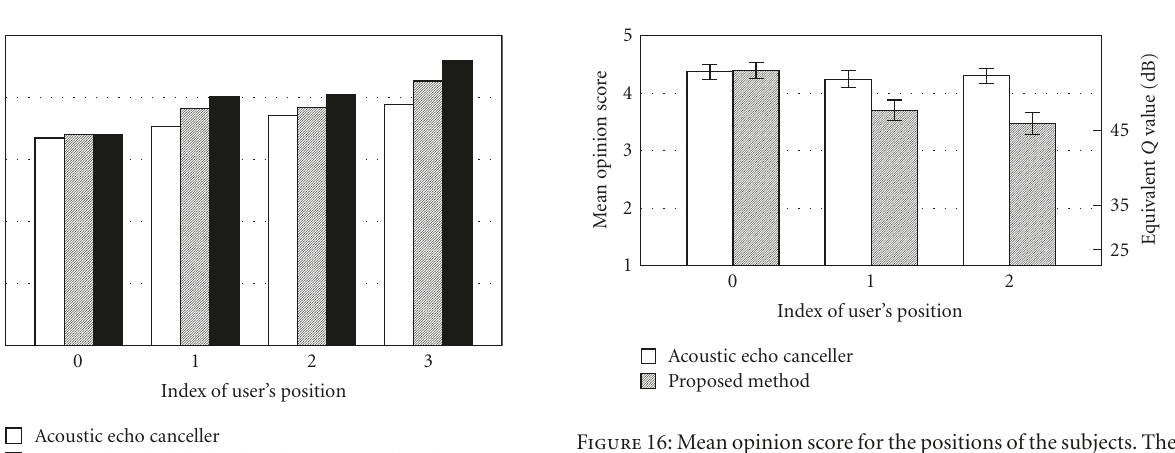
Figure 16: Mean opinion score for the positions of the subjects. The blocks show the means and the error bars show the 95% confidence